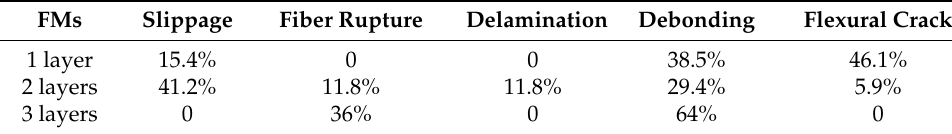
Table 5. The percentage of FMs for each layer based on the number of layers.